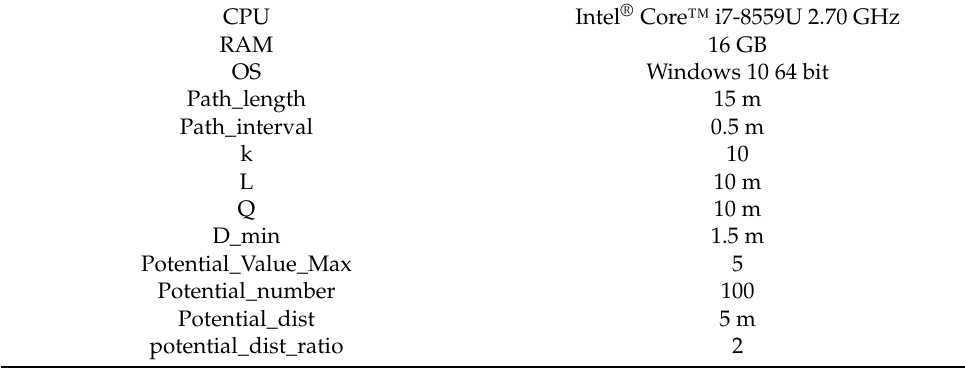
Table 2. Simulation environment.